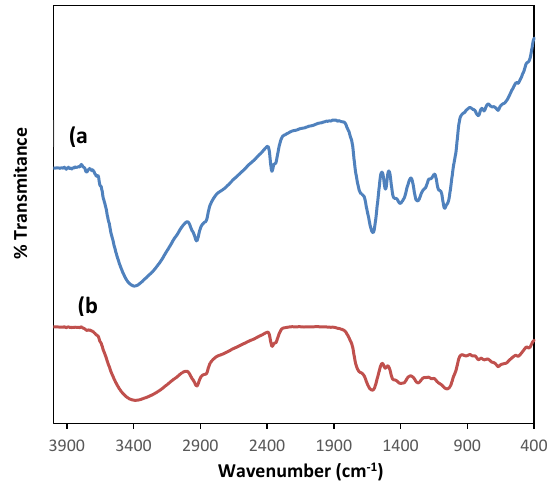
Fig. 3. FT-IR spectrum of Tragopogon graminifolius extract (a), and green Ag synthesized NPs using Tragopogon graminifolius extract (b).